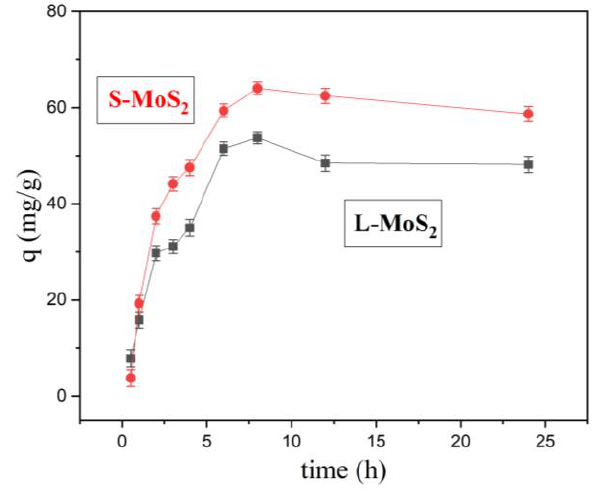
Figure 5. Cu 2+ adsorption capacity at different times (C 0 : 60 mg/L, pH 5).